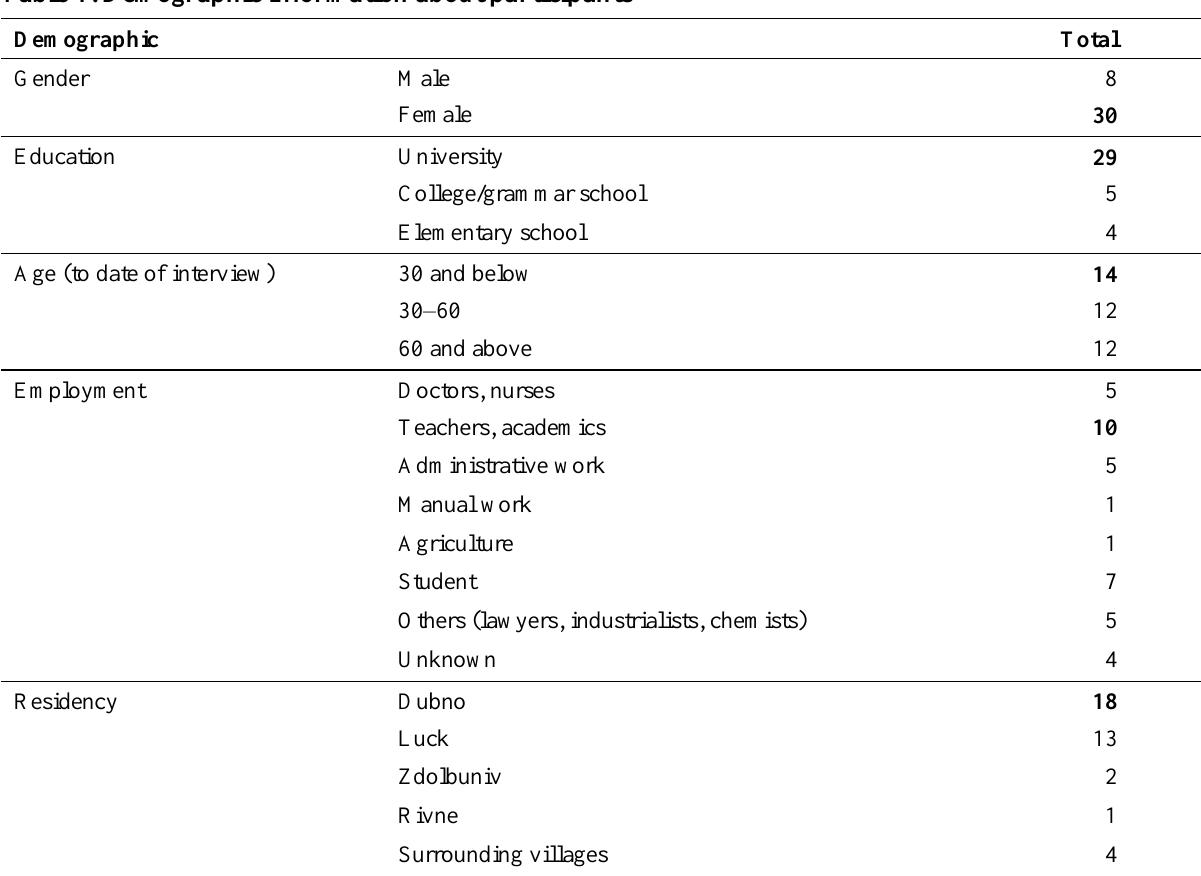
Table 1. Demographic information about